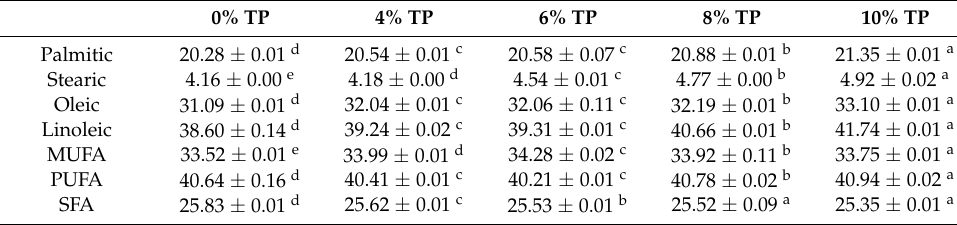
Values in the same row with different letters are significantly different ( p < 0.05) following Fisher’s LSD test. MUFA, monounsaturated fatty acids; PUFA, polyunsaturated fatty acids; SFA, saturated fatty acids. The ANOVA (not presented) highlighted significant differences ( p ≤ 0.05) among samples for all fatty acids. The palmitic, stearic, oleic, and linoleic acids in the control